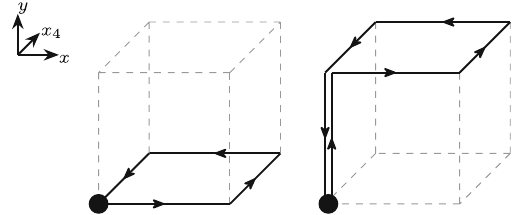
Fig. 2 A pair of paths of closed loops defining a contribution to the magnetic current in the z direction, according to [19]